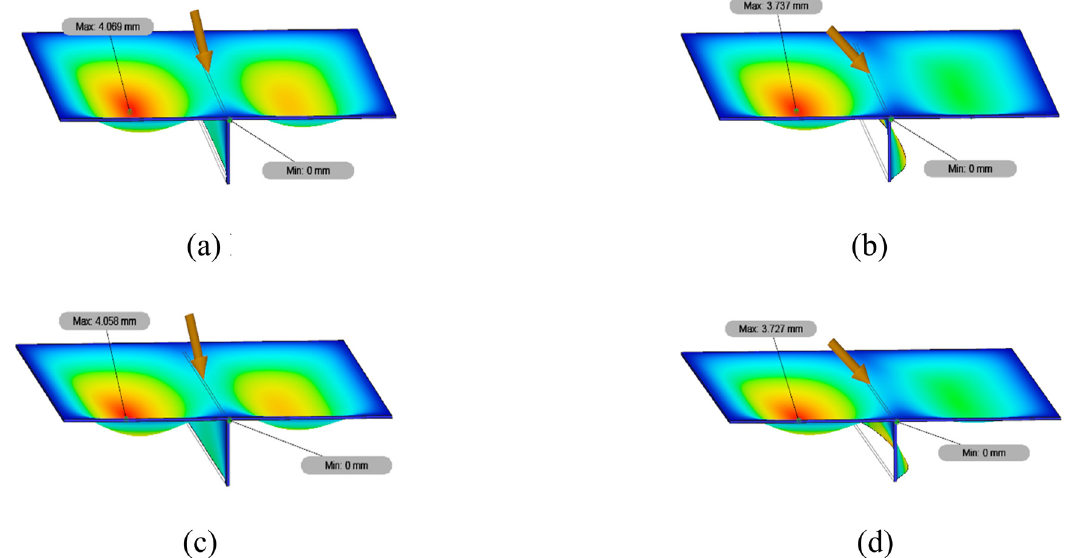
Figure 18: The displacement contour of sti ff ened low - carbon steel plate with a global linear load ( Model 2 ) at an angle of ( a ) 15° or ( b ) 45° and sti ff ened medium - carbon steel plate with a global linear load ( Model 6 ) at an angle of ( c ) 15° or ( d )